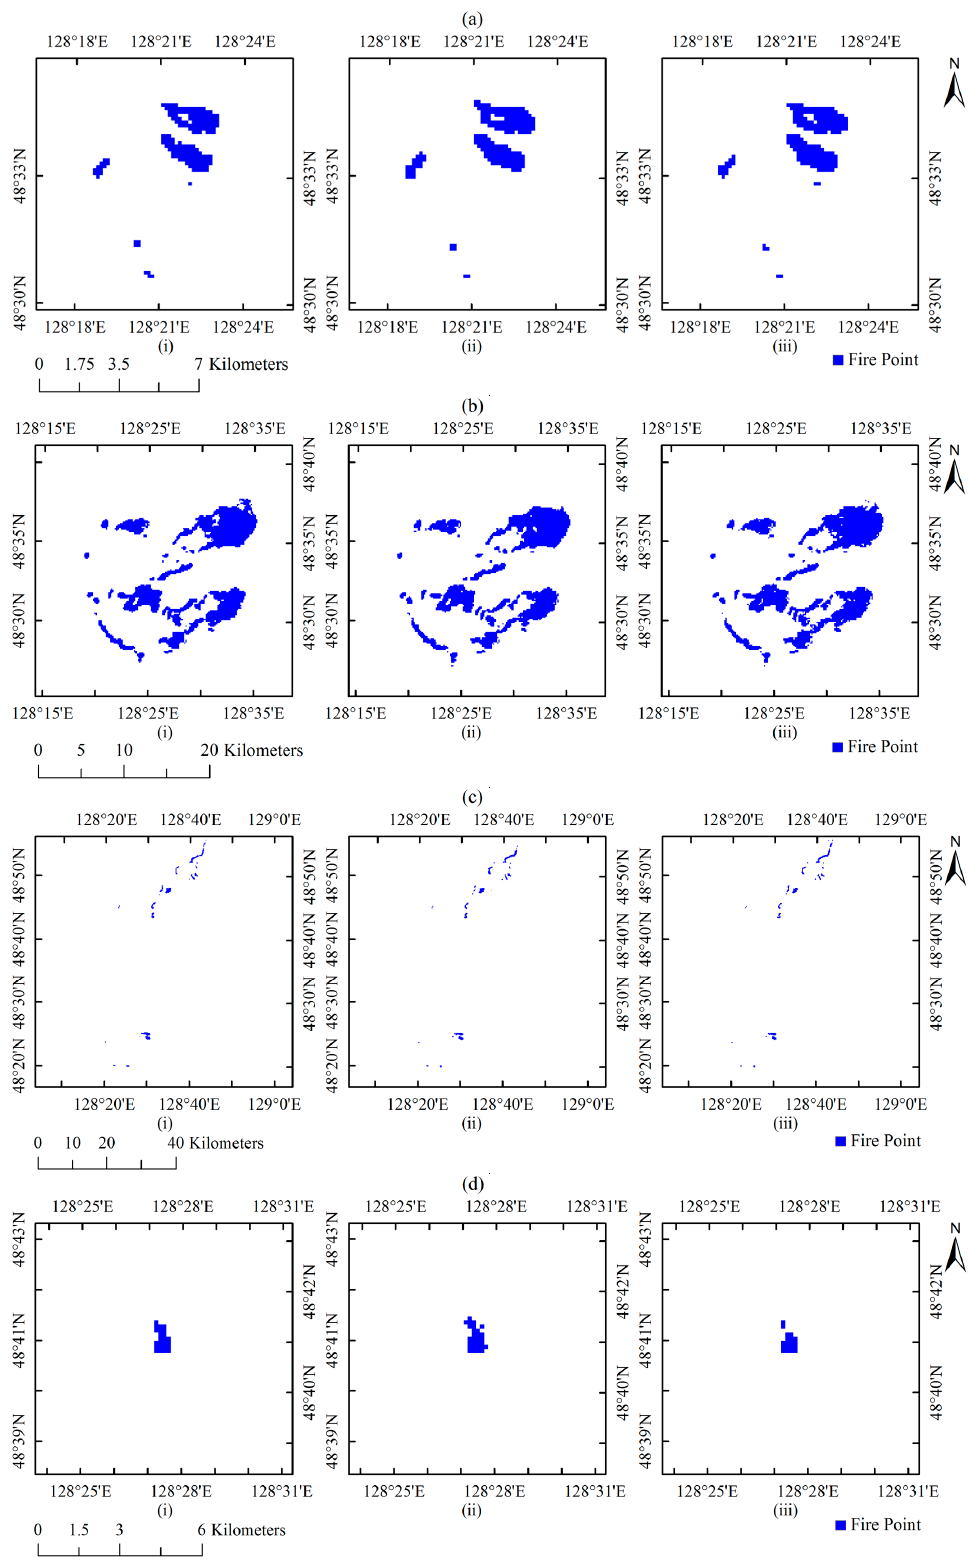
Figure 13. Ground reference data ( i ) and forest fire detection results by contextual algorithm ( ii ) and STM ( iii ) for the days: 28 April 2009 ( a ); 29 April 2009 ( b ); 3 May 2009 ( c ); and 11 May 2009 ( d ). Table 2. Accuracies of the STM method and contextual algorithm results.